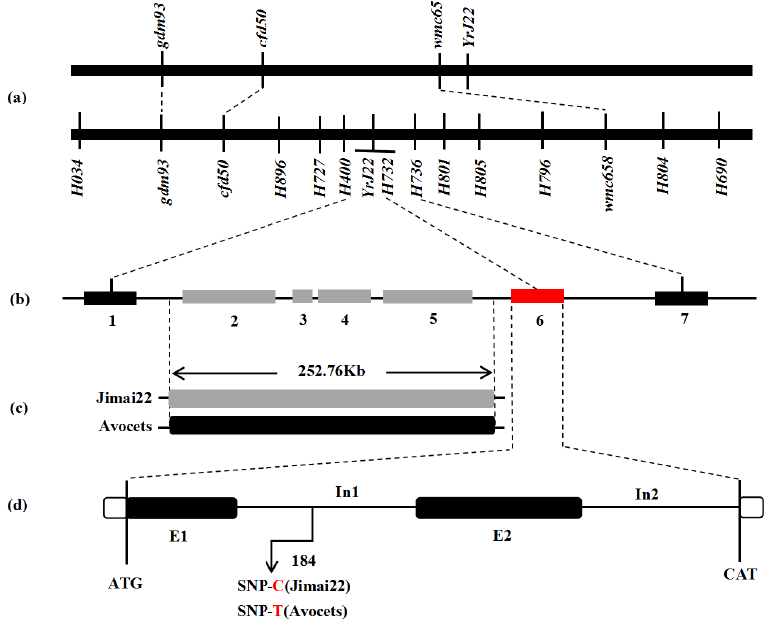
Figure 5. Map-based cloning of the stripe-rust-resistance gene YrJ22. ( a ) Genetic maps from a previous study [45] and the present work (lower). ( b ) Physical map of seven polymorphism genes between Jimai 22 and Avocet S. 1: TraesCS2A01G5740000 , 2: TraesCS2A01G572900 , 3: TraesCS2A01G5740100 , 4: TraesCS2A01G573000 , 5: TraesCS2A01G573100 , 6: TraesCS2A01G573200 , 7: TraesCS2A01G573600. ( c ) Black box represents region that could be amplified in Avocet S and susceptible lines; grey box indicates the region that is absent in Jimai 22. ( d ) Genomic structure of TraesCS2A01G573200 in reference sequences of CS. Abbreviations include exon (E) and intron (In).